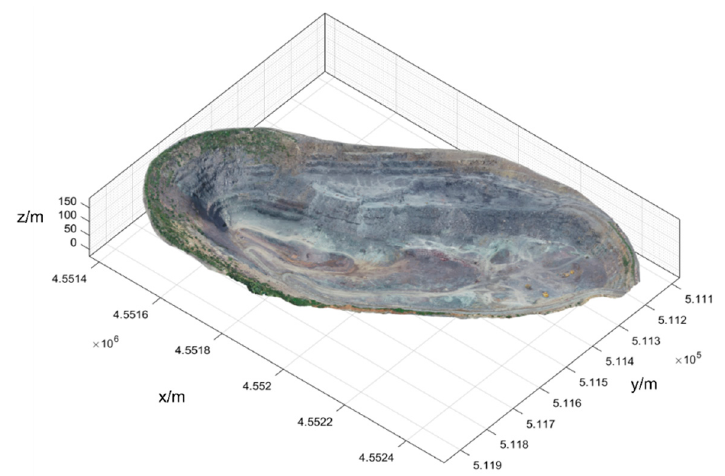
Figure 11. Point-cloud model of open-pit mines.